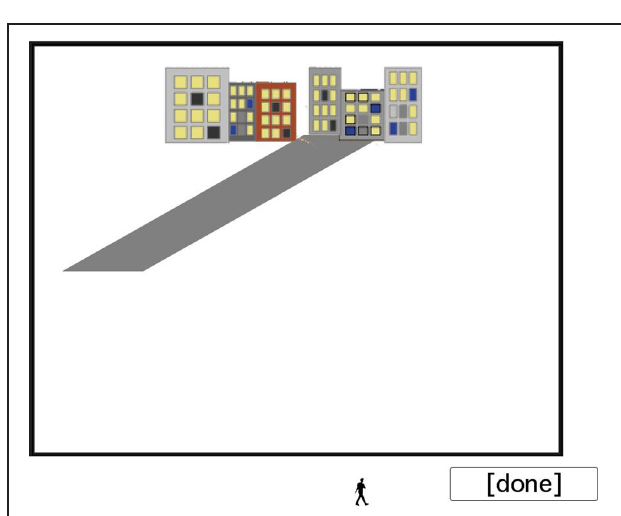
FIGURE 1 | Visual scenes like this one accompanied target sentences. The silhouette figure at the bottom is the character in its starting